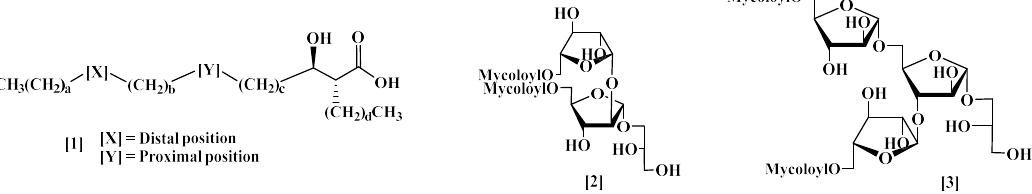
Figure 1. Generalised structure of mycolic acids ( 1 ), dimycoloyl diarabinoglycerol (DMAG) ( 2 ) and dimycoloyl triarabinoglycerol (DMTAG) ( 3 ).